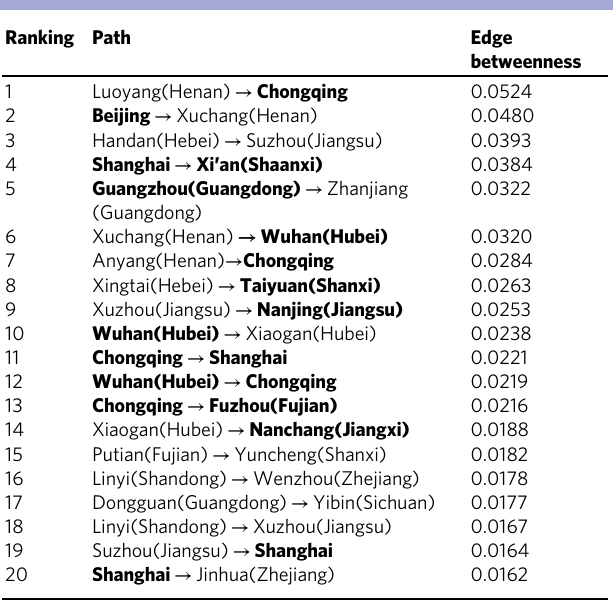
Table 2 Key informal adoption paths with the highest edge betweennesses in the city-level informal adoption